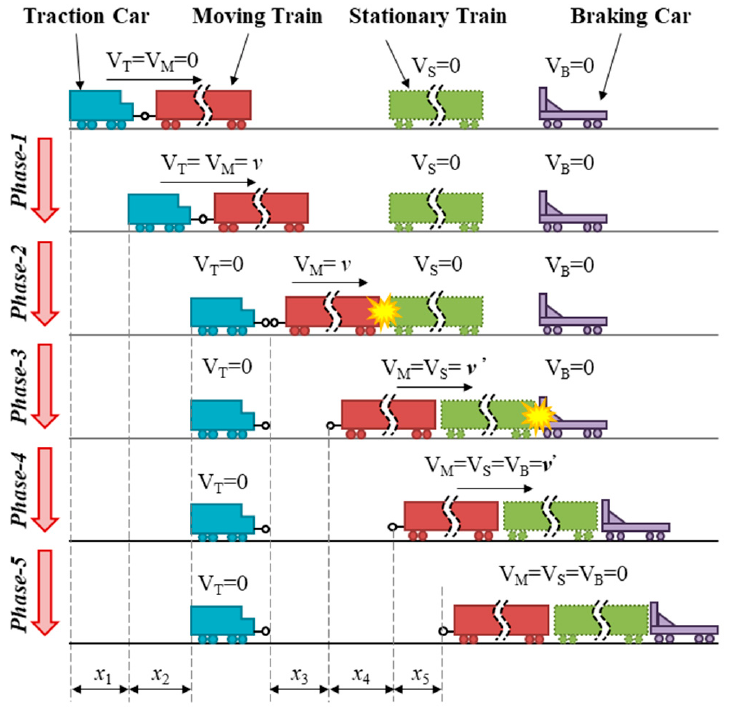
Figure 1. Schematic diagram of train multi–group collision process.